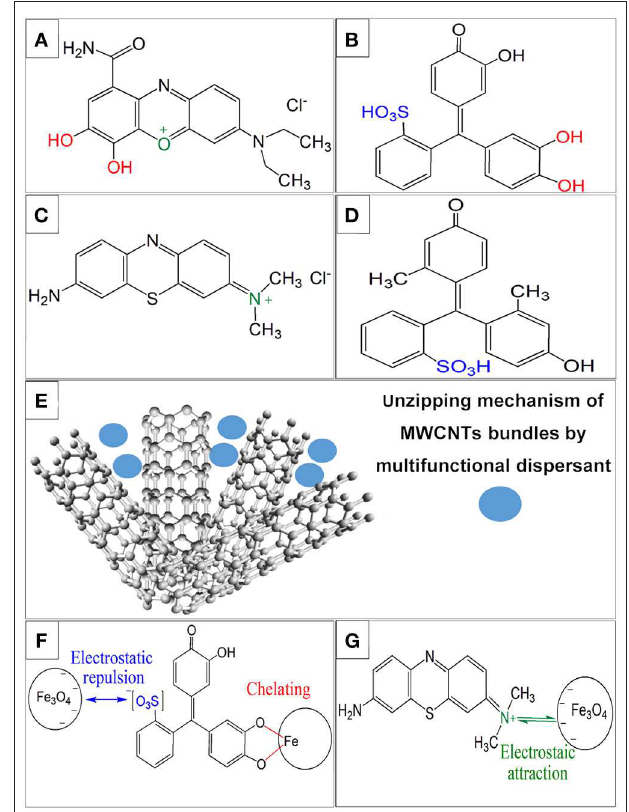
FIGURE 1 | Chemical structures of (A) CB, (B) PV, (C) AA, (D) CP and schematics, showing (E) unzipping of MWCNT bundles by dispersants, (F) electrostatic repulsion of PV and Fe 3 O 4 particles and chelating bonding of PV to Fe atoms on the Fe 3 O 4 particle surface, involving a catechol group of PV, (G) electrostatic attraction of AA and Fe 3 O 4 .